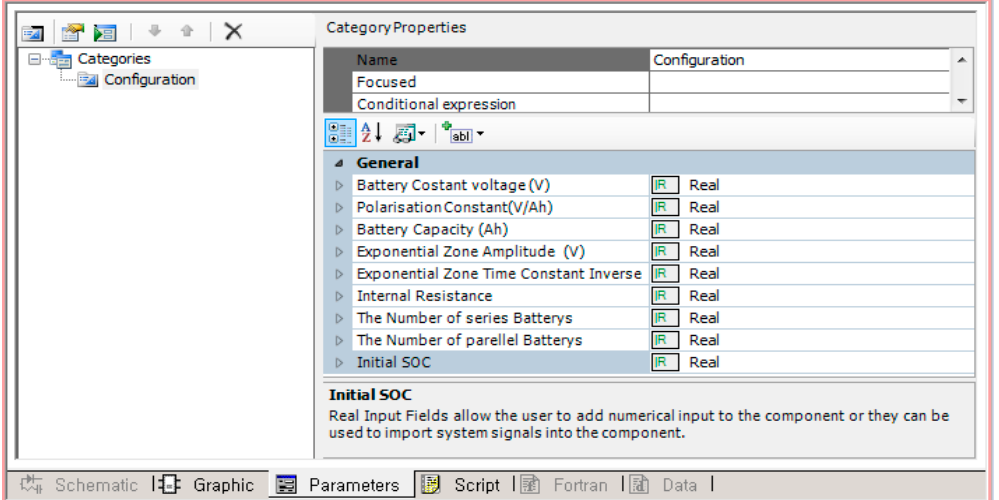
Figure 15. Creation of the battery parameter input window.